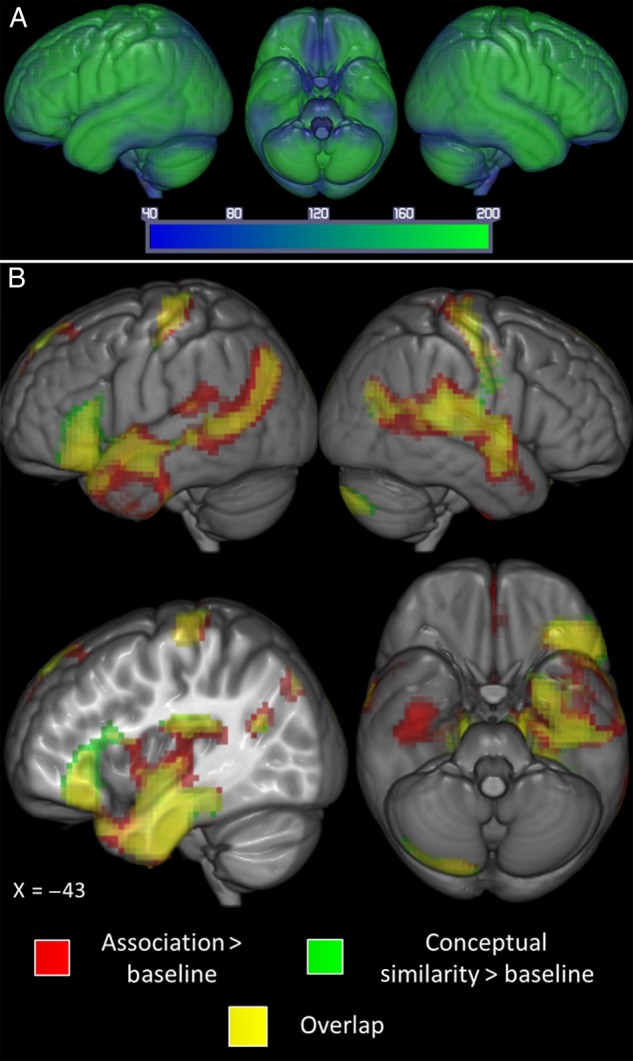
(A) Average temporal signal-to-noise ratio for the smoothed group echo planar imaging data in MNI space. The map is set at a threshold of 40, considered to be the minimum TSNR required to reliably detect differences in signal (Murphy et al. 2007; Simmons et al. 2010; Wang et al. 2013) and is displayed as a range from 40 (dark blue) to 200 (bright green). Use of the dual-echo technique meant signal reached the minimum threshold throughout the ATL and inferior frontal regions with some subregions far exceeding this with values above 200. (B) Significant activation for the contrasts association judgments > letter matching (red) and conceptual similarity judgments > letter matching (green); yellow = overlap. Voxels significant at 0.05 with an FWE correction at the cluster level with a critical cluster level of 0.05.